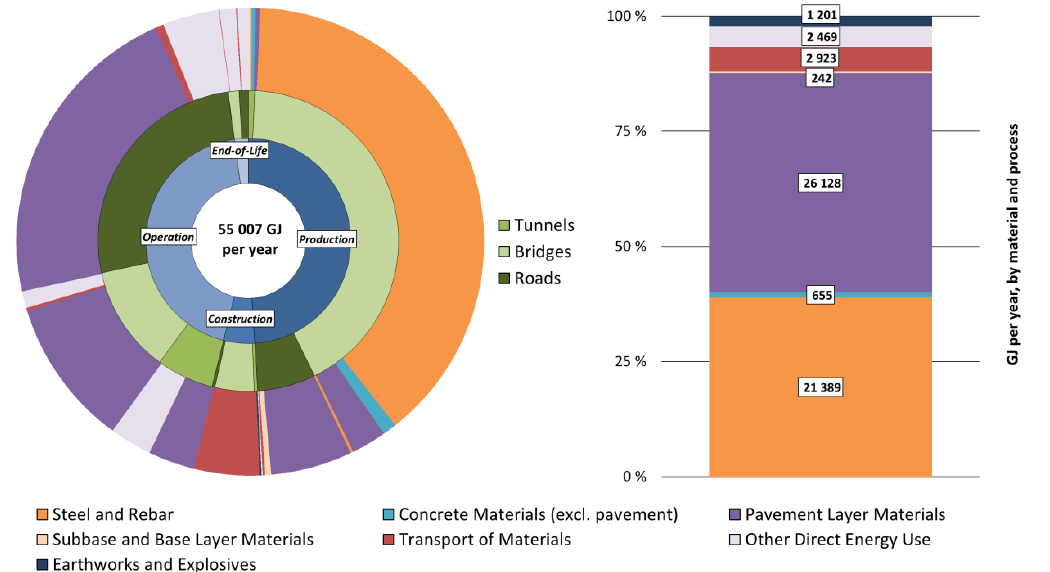
Figure 8. Contribution analysis for cumulative energy demand (CED) for Alternative